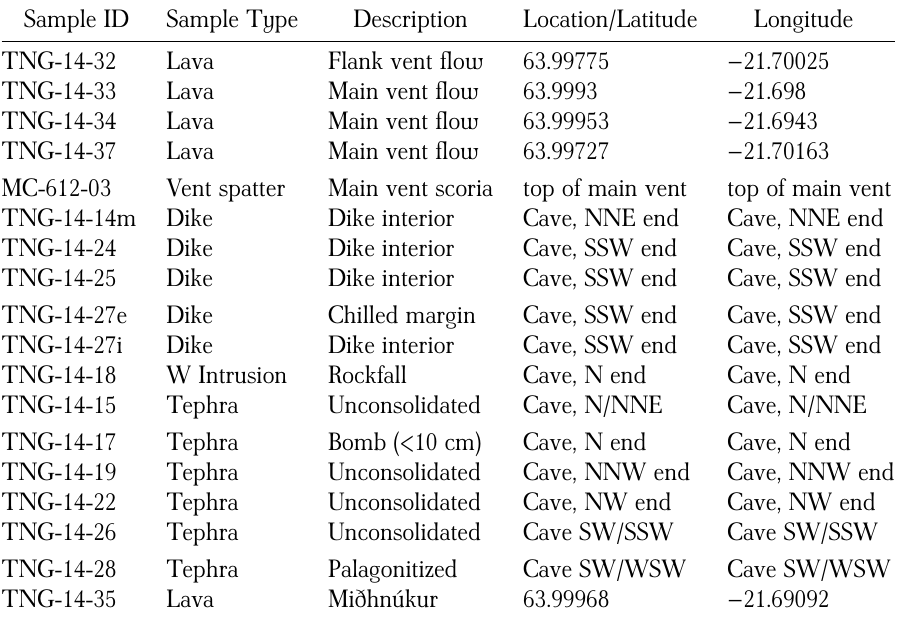
Table 1: Thríhnúkagígur samples are subdivided into three groups: the erupted lavas, the intrusive components (dikes and the western wall intrusion), and tephra; along with a Miðhnúkur lava